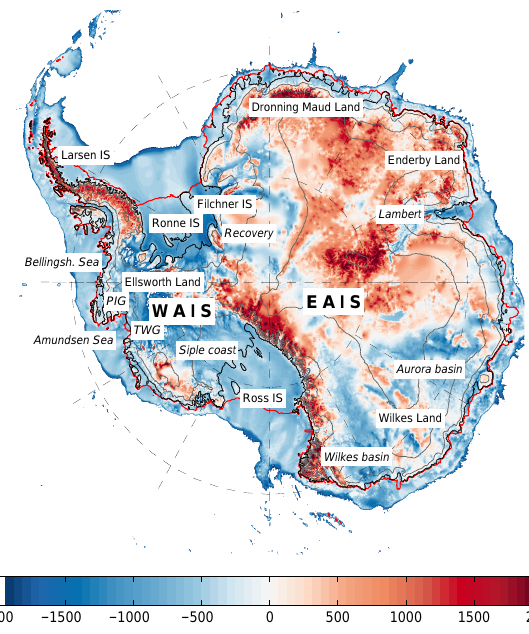
Figure 3. Bedrock topography (colour (ma.s.l.); Fretwell et al., 2013) and surface contours (grey; every 1000m) of the Antarctic ice sheet and ice sheet features mentioned in this paper. WAIS is the West Antarctic ice sheet; EAIS is East Antarctic ice sheet; PIG is Pine Island Glacier; TWG is Thwaites Glacier; IS is ice shelf. Grounding lines are shown in black; ice shelf edges are shown as a red